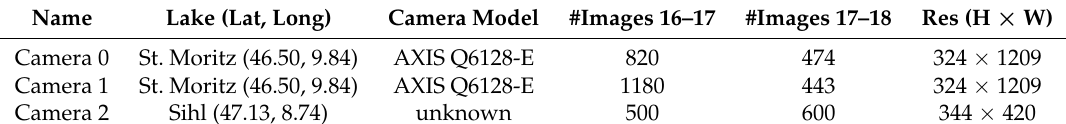
Table 6. Details of the Photi-LakeIce dataset. Lat and Long respectively denote latitude ( ◦ North) and longitude ( ◦ East) of the approximate camera location. Res stands for resolution and H and W represent height and width of the image in pixels (after cropping).